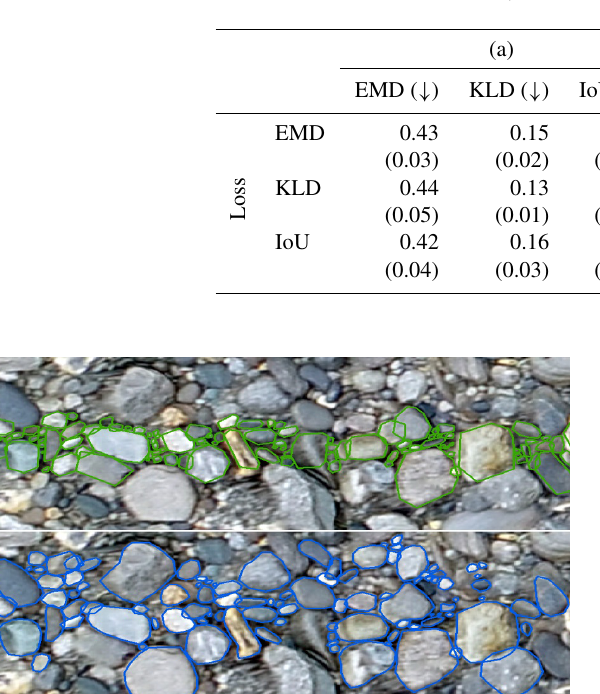
Figure 6. Comparison of digital line samples with 22 in situ line samples collected in the field. Table 1. Results for GRAINet regressing (a) the relative frequency distribution and (b) the relative volume distribution. Mean and standard deviation (in parenthesis) for the random 10-fold cross-validation. The rows correspond to the CNN models trained with the respective loss function. Arrows indicate if the error metric is minimized ( ↓ , lower is better) or maximized ( ↑ , higher is better).